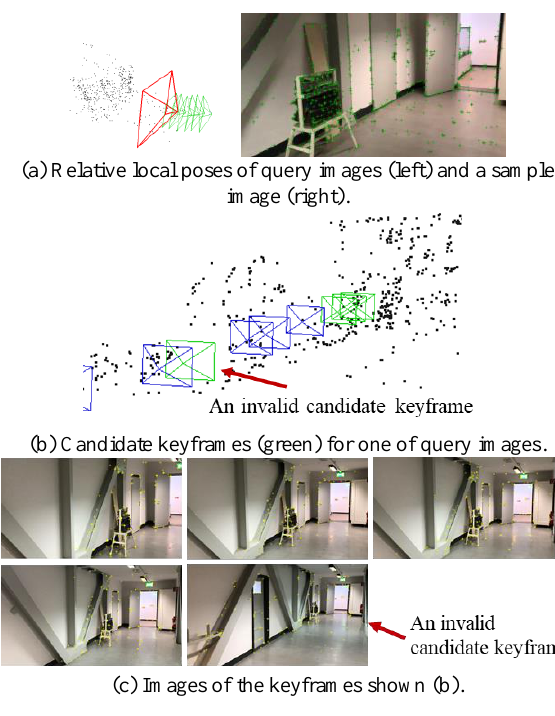
Figure 5. The effect of relative poses on detecting invalid image retrieval